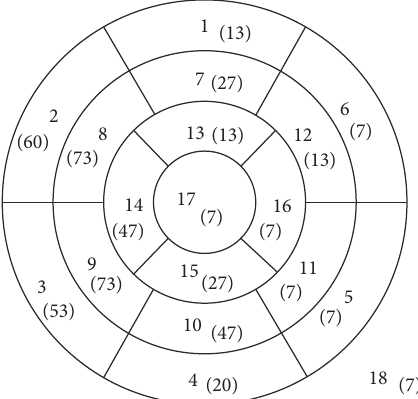
Figure 1: Schematic diagram of the AHA myocardial segments [20], with segment 18 representing the papillary muscles. The number in parentheses is thepercentage of positive LGE for that segment in our patient population, with total patients who are LGE positive as the